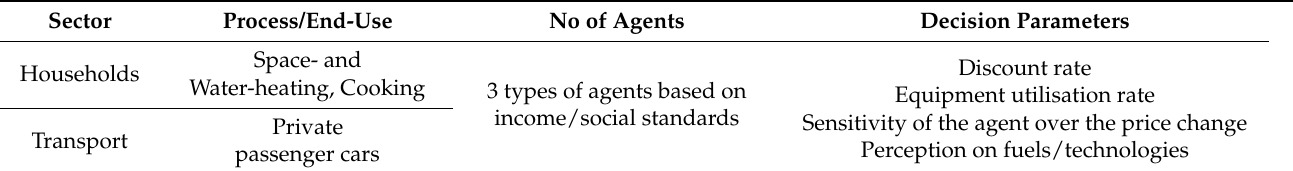
Table 3. Agent heterogeneity in E3-ISL demand module